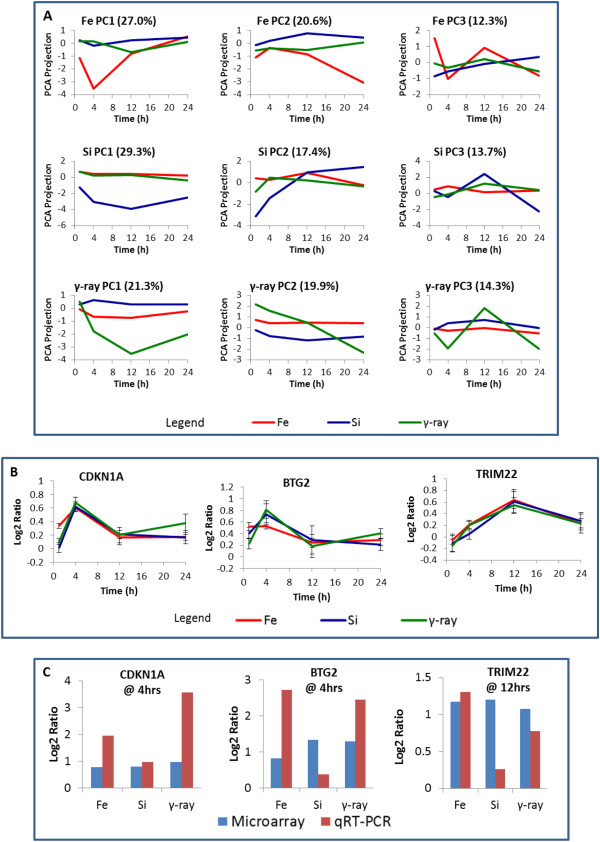
Temporal patterns of significantly changed genes in response to 56Fe, 28Si and γ-ray irradiations. A, The major temporal patterns of genes whose expression is associated with a particular radiation type are displayed. These patterns correspond to the first three components from principal component analysis (PCA). B, Genes associated with p53 signaling and/or involved in cell cycle regulation exhibited similar kinetics of expression in response to different radiation qualities. Average log2 ratios from three replicate experiments were used in the plot. Error bar: standard error. C, Using a single representative experiment, microarray expression values at a given time for the genes in Figure 4B were validated using qRT-PCR. The log2-ratios of irradiated vs. mock samples from both qRT-PCR and microarray analysis of the corresponding replicate were plotted. The up-regulation of these genes at the indicated time points was confirmed.